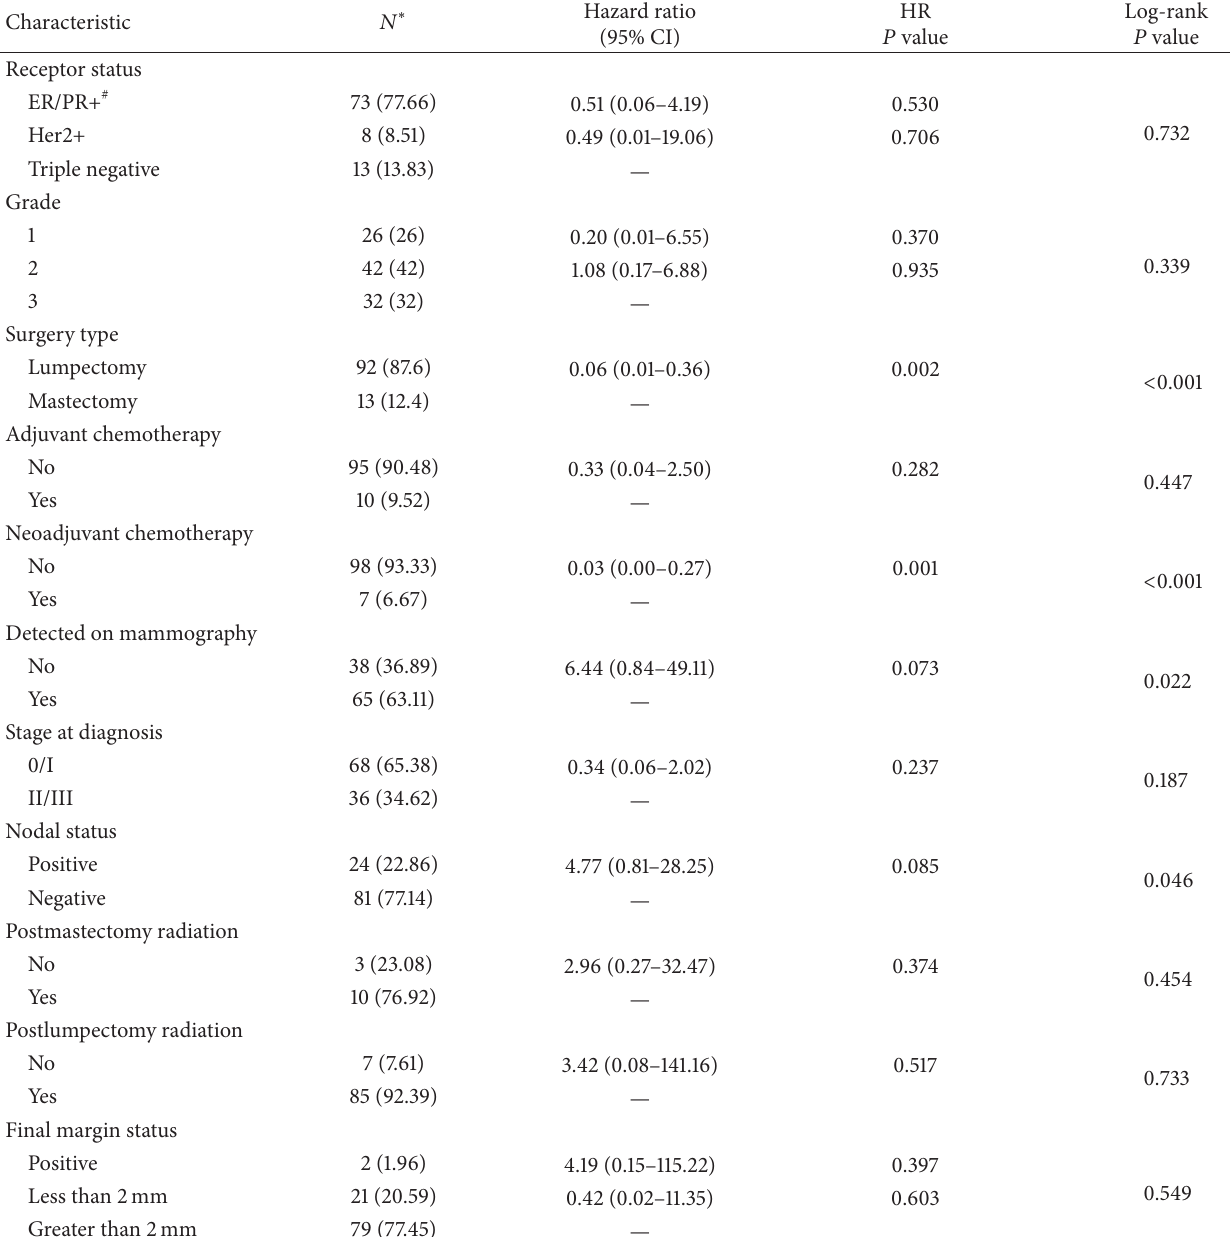
Table 4: Univariate analysis of risk factors for distant recurrence-free survival in older women.